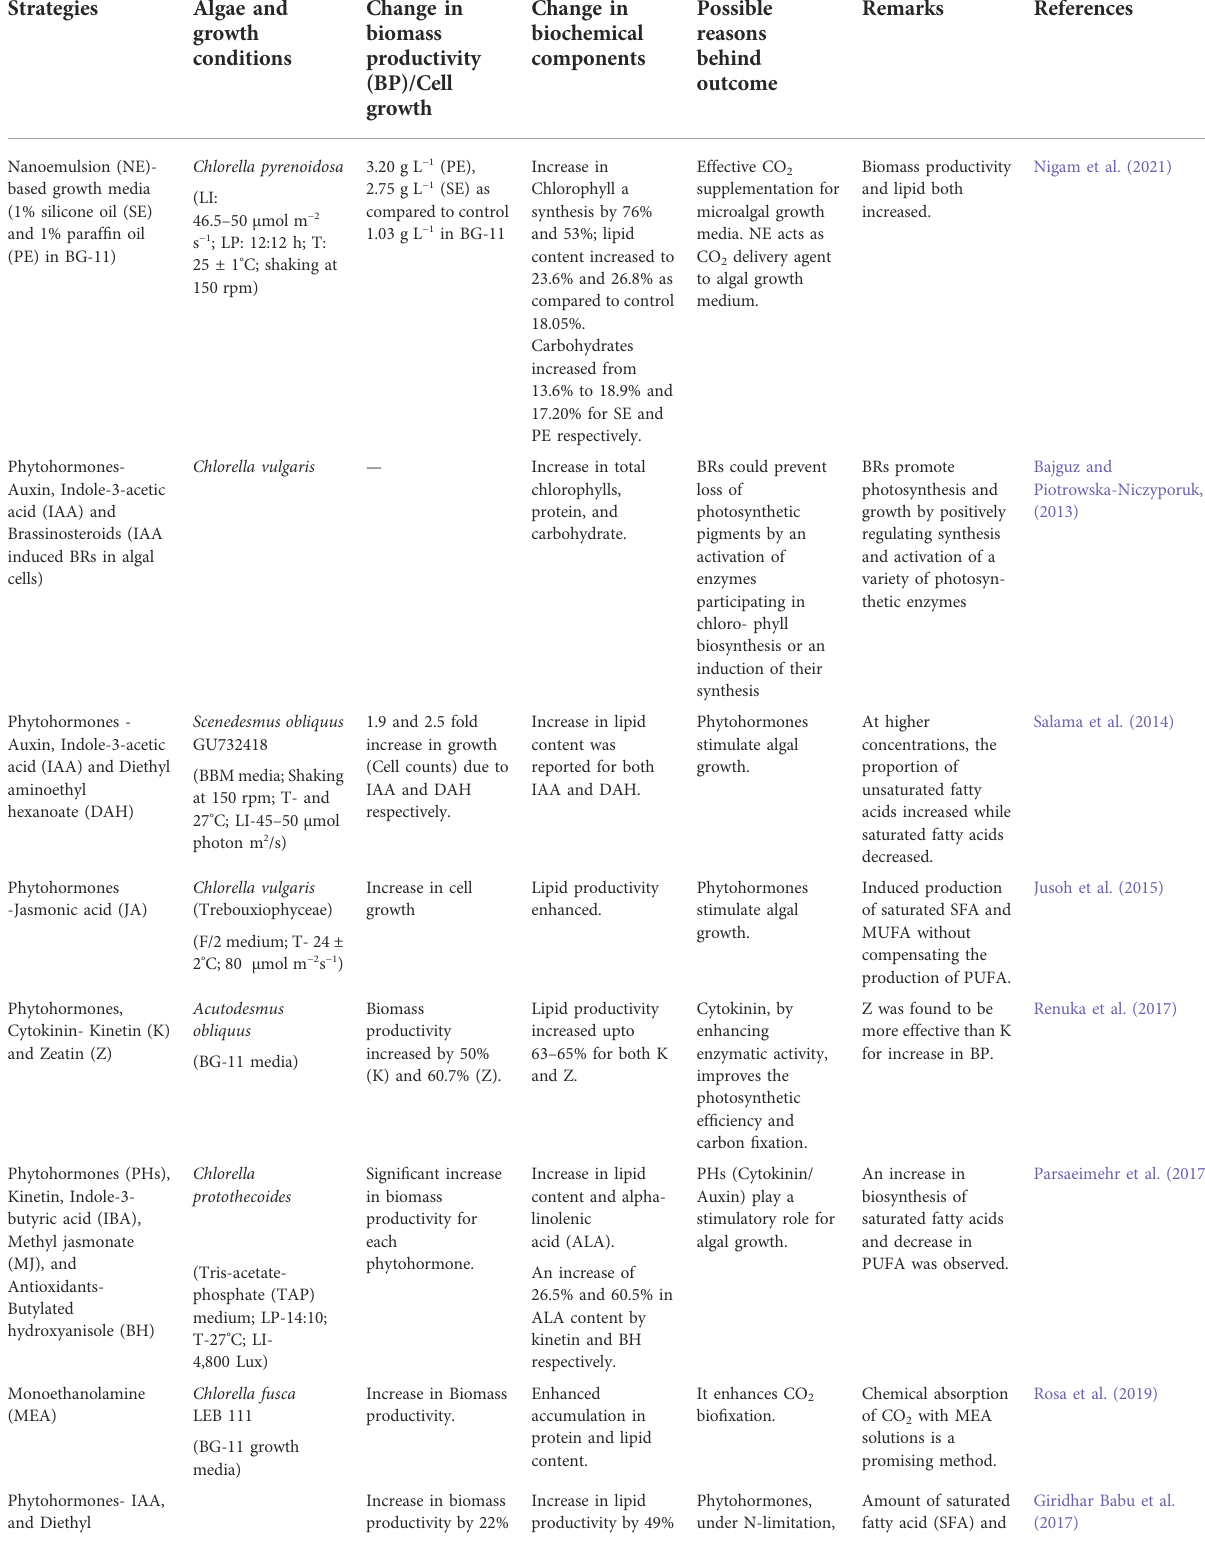
TABLE 2 Abiotic strategies to enhance algal productivity.